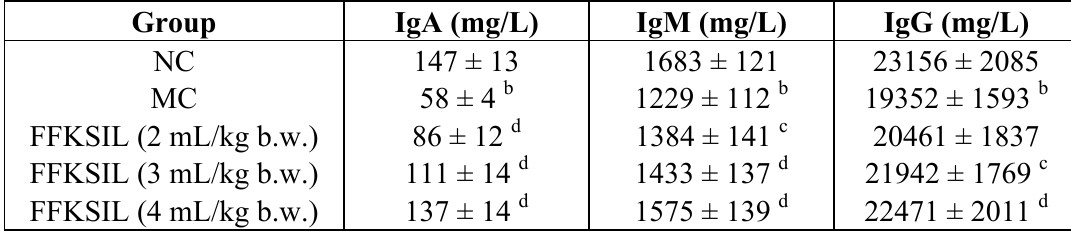
Table 1. Effect of FFKSIL treatment on serum IgA, IgG and IgM.